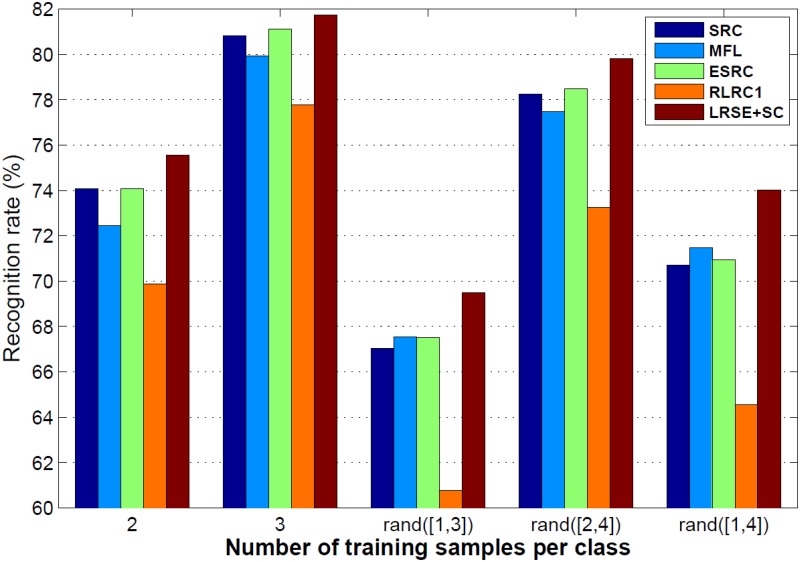
Recognition rate versus training sample number on FERET database.
rand([1, 3]) is a random number between 1 and 3.